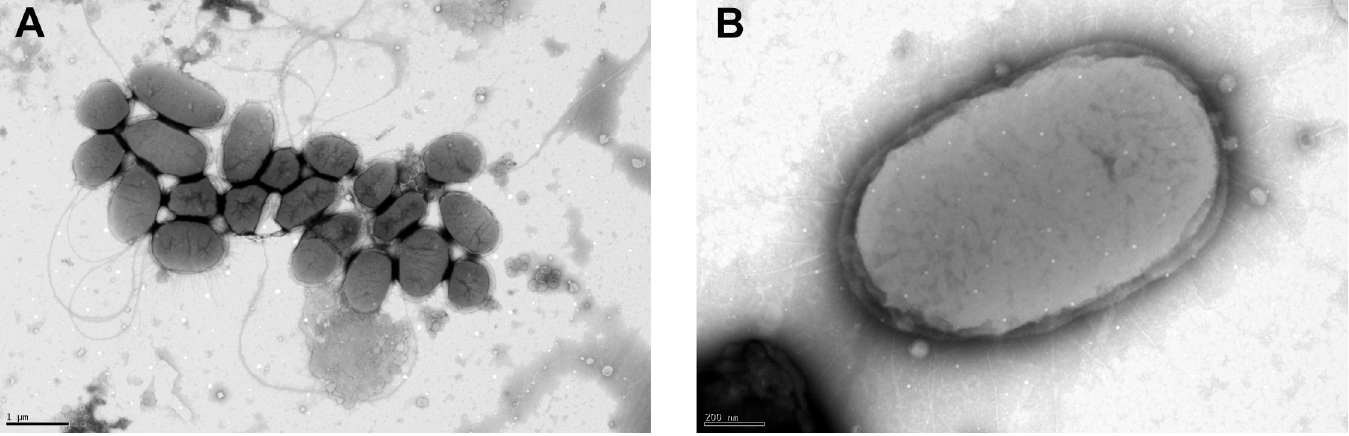
Fig 1. Transmission electron microscopy images of LVF3 R . The micrograph (A) shows the typically observed cell morphotypes of S . marcescens strain LVF3 R . Micrograph (B) shows S . marcescens LVF3 R surrounded by its active prophages. Cells were grown for 24 h at 30˚C in TSB-10 medium, negatively stained and used for TEM